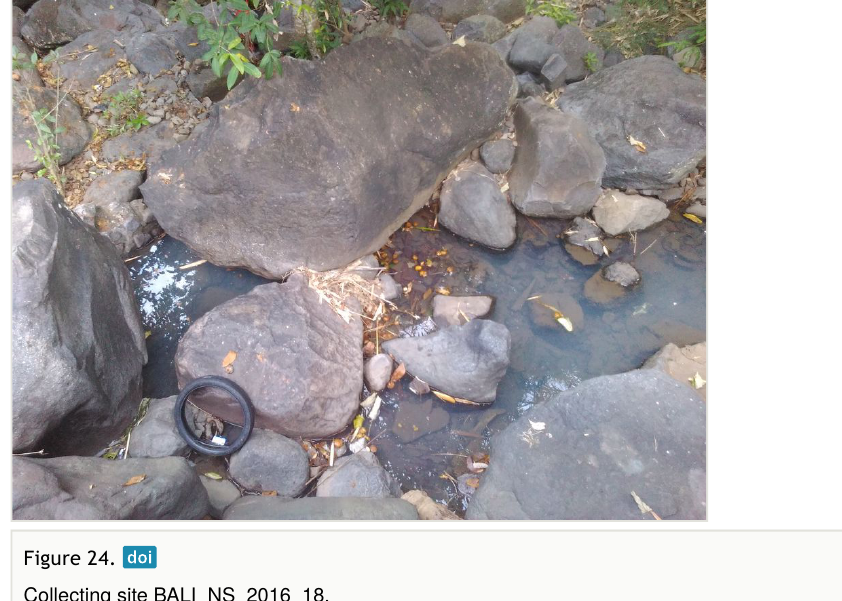
Collecting site